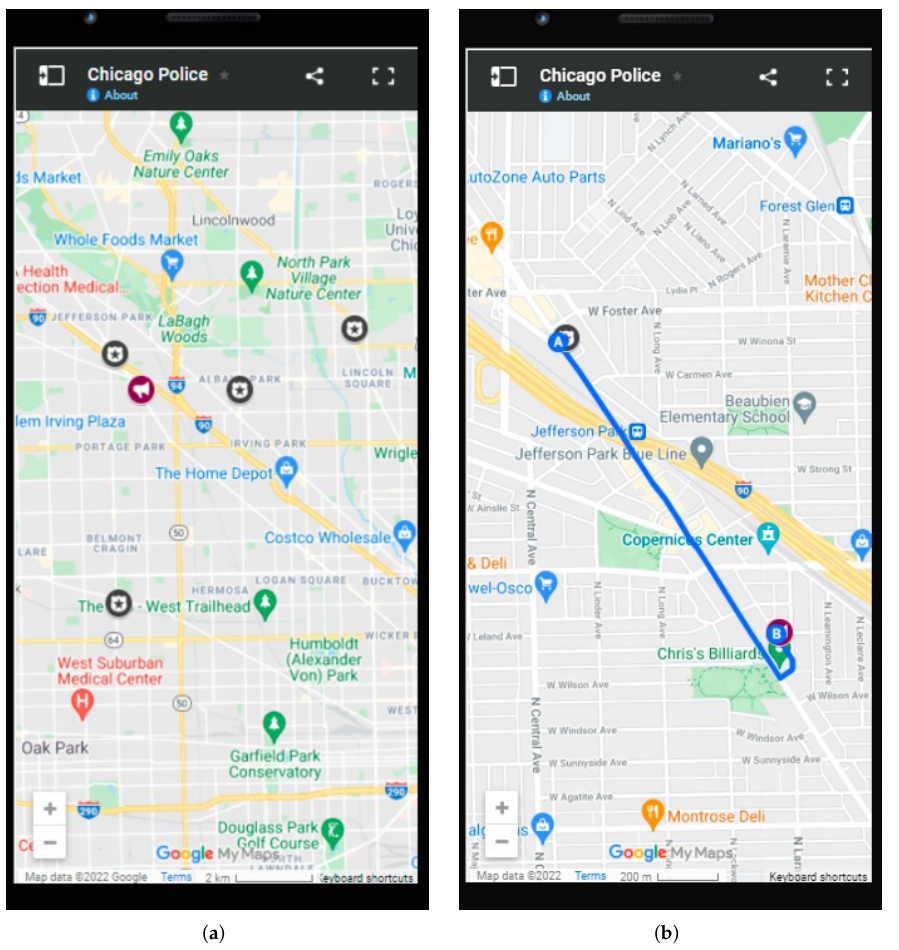
Figure 5. Prototype application for finding the location of the nearest police station. ( a ) Nearby police quarters. ( b ) Direction to the crime